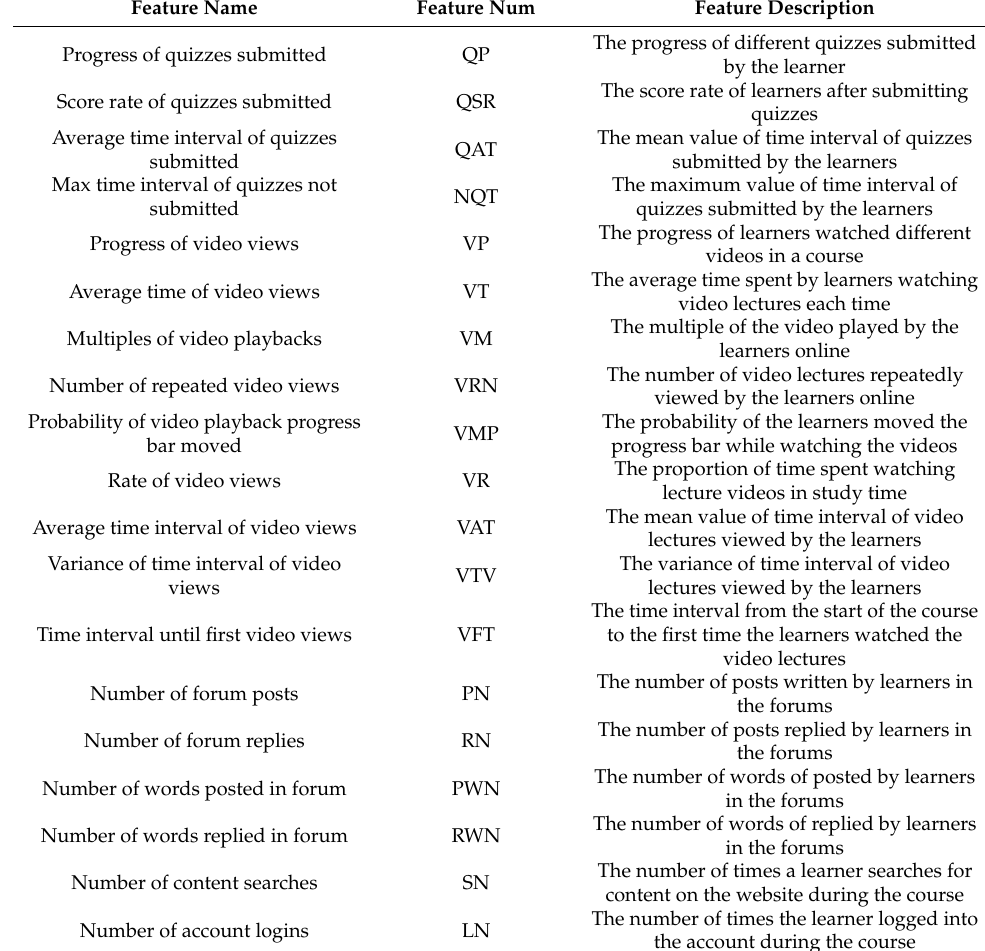
Table 2. The statistical behavioral features of